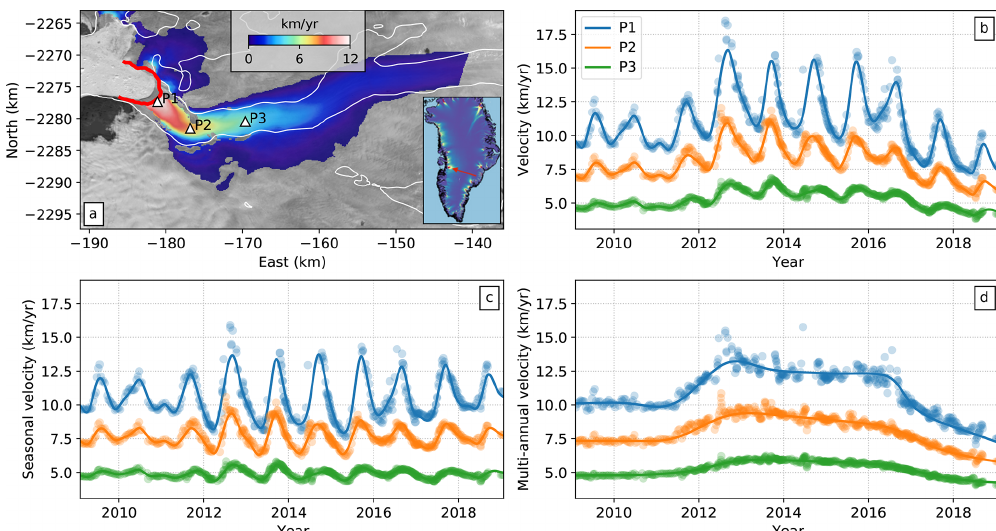
Figure 1. Sermeq Kujalleq (Jakobshavn Isbræ) mean velocity field and select velocity time series. (a) Mean velocity between 2009 and 2019 in Polar Stereographic North (EPSG:3413) coordinates. The background image is a Landsat 8 image acquired in August 2017. White lines correspond to the bed topography (BedMachine V3) at sea level, and the red line indicates the winter 2017 terminus position (for all subsequent map figures). White triangles indicate the points P1–P3 from which data shown in (b–d) are taken. Inset shows (with red arrow) the approximate study area within Greenland with mean velocities from Joughin et al. (2011). (b) Time-dependent speed at points P1–P3. (c) Short-term velocity time series showing predominantly seasonal variations. For each time series, mean velocities for 2009–2019 have been added as offsets for visual clarity. (d) Long-term velocity time series showing the 2012 speedup and 2017 slowdown. In (b–d) , solid lines show our model results while dots indicate (b) observed speeds or (c, d) detrended observations. The detrended short-term observations in (c) are the observed speeds minus the estimated integrated B-splines. The detrended long-term observations in (d) are the observed speeds minus the estimated seasonal